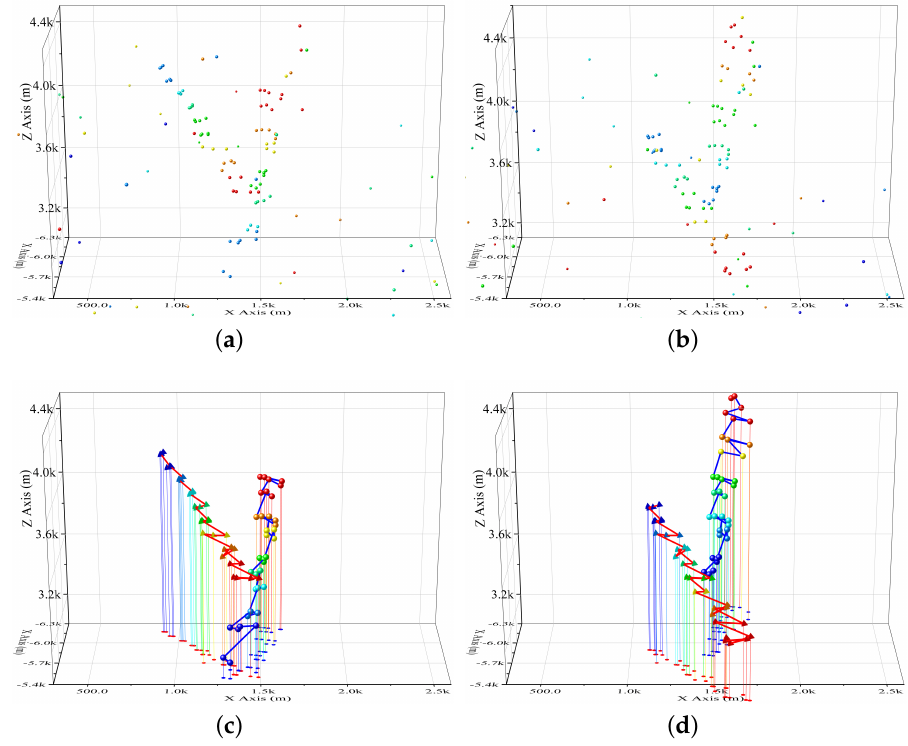
Figure 10. ( a ) The measurement of 166th to 175th scans. ( b ) The measurement of 171th to 180th scans. ( c ) The two obtained tracks corresponding to Figure 10a. ( d ) The two obtained tracks corresponding to Figure